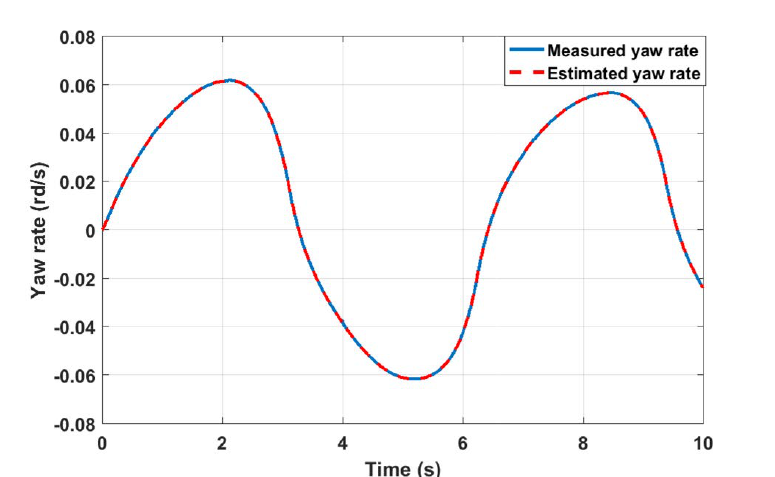
Figure 10. Estimated vehicle Yaw rate with FTC